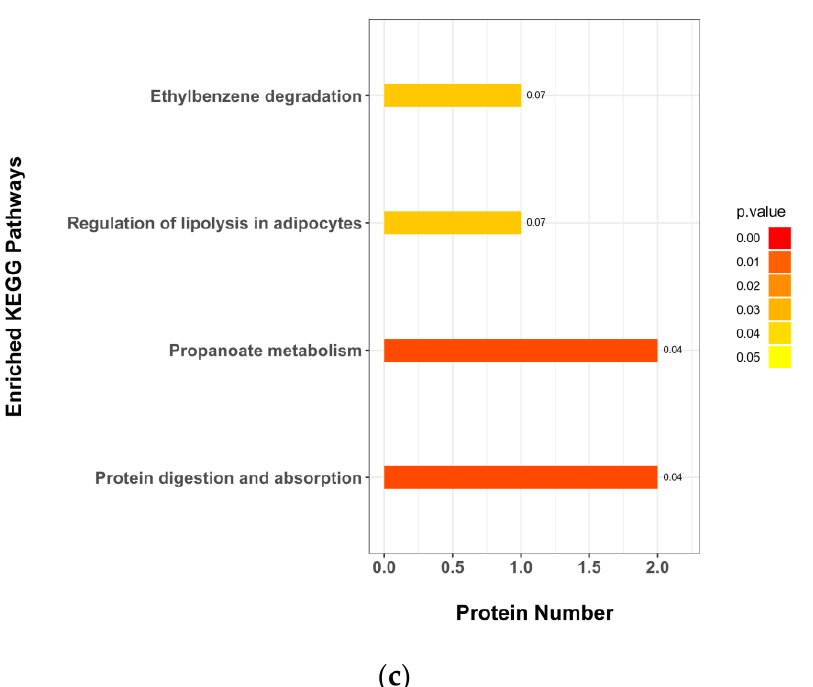
Figure 4. Bioinformatics analysis of differential metabolites. ( a ) Hierarchical clustering heatmap of significant differential metabolites. Note: Each row in the figure represented a differential metabolite, and each column represented a group of samples. Red represented significant up-regulation, blue represented significant down-regulation, and the depth of the color represented the degree of up-regulation. Metabolites with similar expression patterns gather under the same cluster on the left. ( b ) Correlation heatmap of significant differential metabolites and intestinal microorganisms. Note: Red indicated a positive correlation, blue indicated a negative correlation, and white indicated a non-significant correlation. The color depth was related to theabsolute value of the correlation coefficient that was, the higher the degree of positive or negative correlation, and the darker the color was. The size of the square was related to the significance of the correlation, the smaller the p-value, the stronger the correlation, and the larger the square size was. ( c ) KEGG pathway annotation and analysis. Note: The vertical axis in the bar graph represented each KEGG metabolic pathway, and the horizontal axis represented the number of differentially expressed metabolites contained in each KEGG metabolic pathway. The color represented the p -value of the enrichment analysis, the darker the color, the smaller the p -value was, and the more significant the degree of enrichment, and the number on the column represented the rich factor.